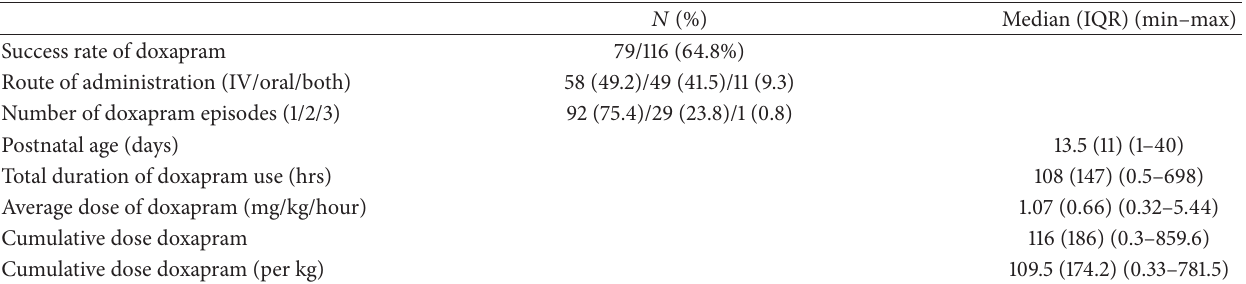
Table 2: Doxapram